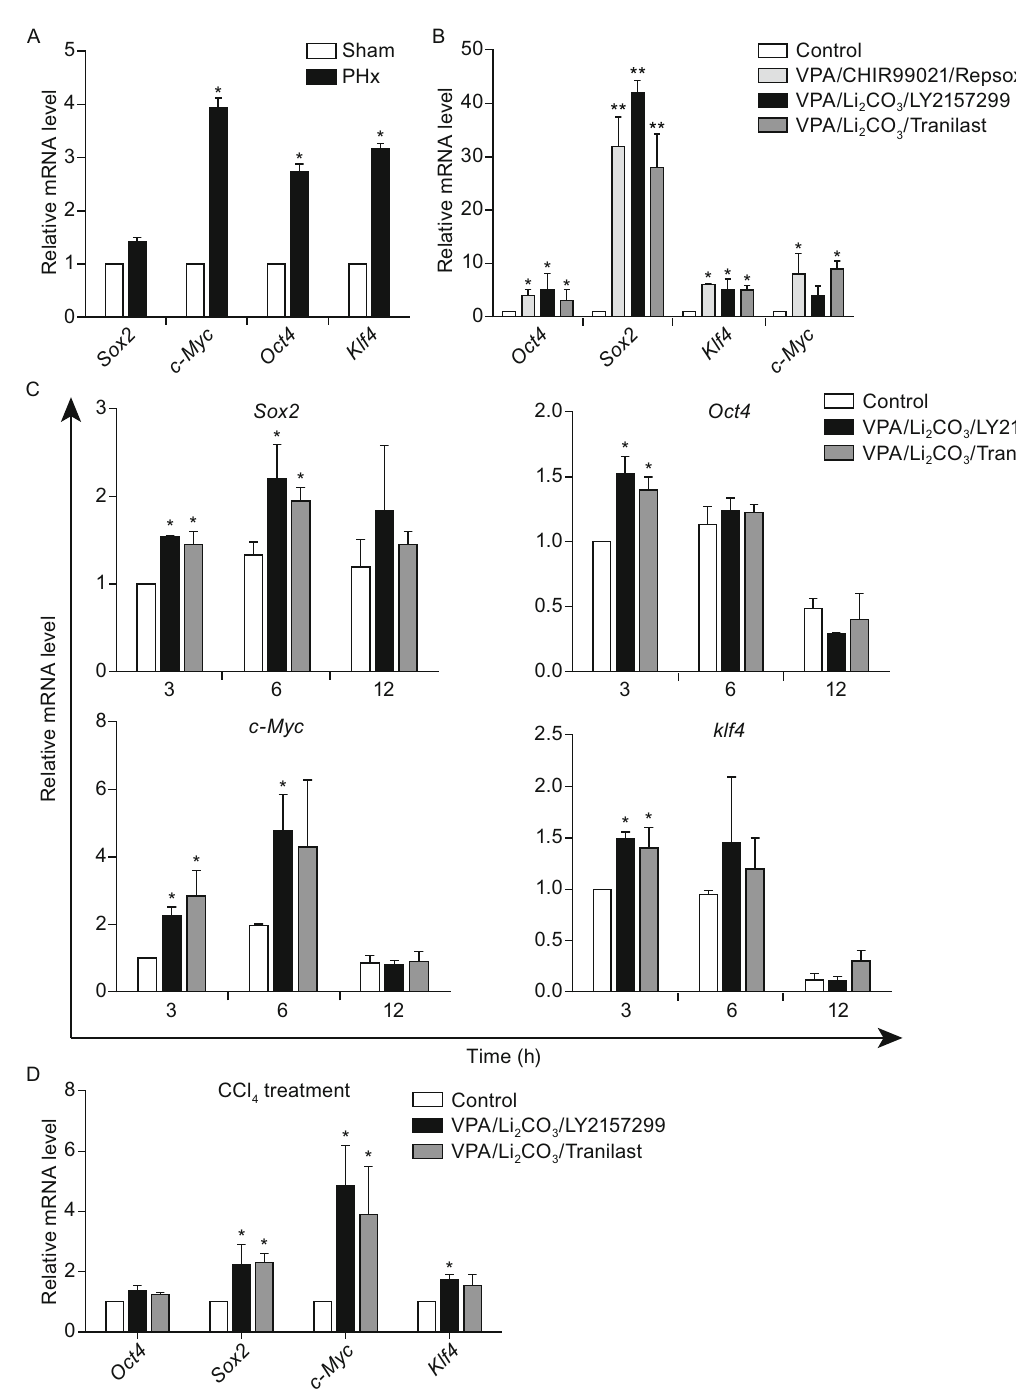
Figure 4. Combination of chemical compounds enhances pluripotent gene expression. (A) qRT-PCR analysis of pluripotent gene expressions in liver tissues 6 h after partial hepatectomy (PHx). (B) qRT-PCR analysis of endogenous pluripotency gene expression in OG2-MEFs 6 h after treatment with Yamanaka factors and diverse combination of chemical compounds. (C) Analyze the expression of pluripotent genes by qRT-PCR at different time points in liver tissues, after treatment with diverse drug cocktails in mouse model of liver regeneration by partial hepatectomy (PHx). (D) Analysis of pluripotent gene expression in liver tissues by qRT- PCR, 6 h after treatment with diverse drug cocktails in CCl 4 induced acute liver injury mouse model. All data are presented as mean ± SD. * P < 0.05 vs. sham or